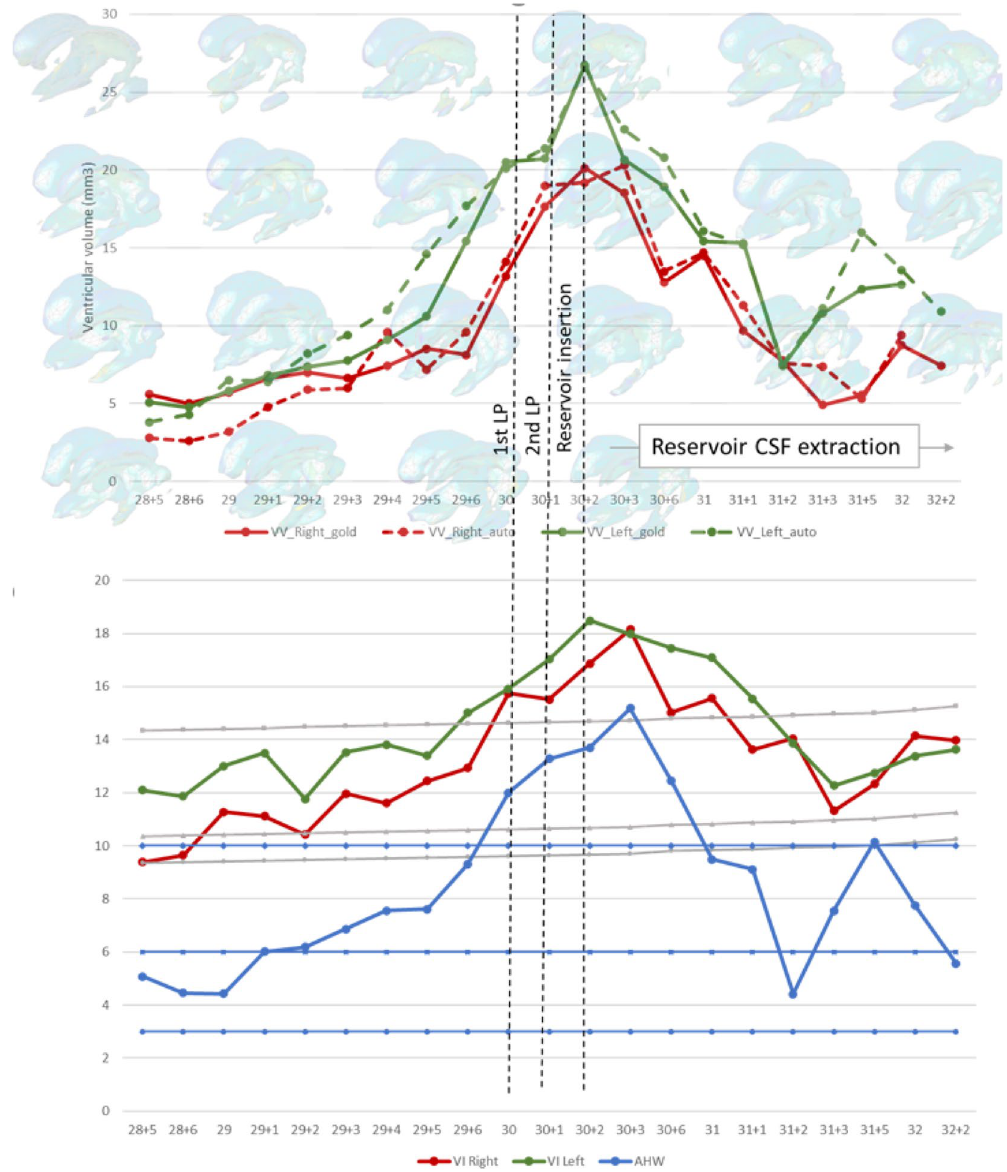
Figure 5. Temporal evolution of ventricular index (VI), anterior horn width (AHW) and ventricular volume in one of the included patients. This patient was randomized to the high threshold intervention group for the ELVIS trial. The volume of the ventricles grows over time. On day 12, an intraventricular catheter was placed to allow CSF removal, allowing for a reduction of ventricular